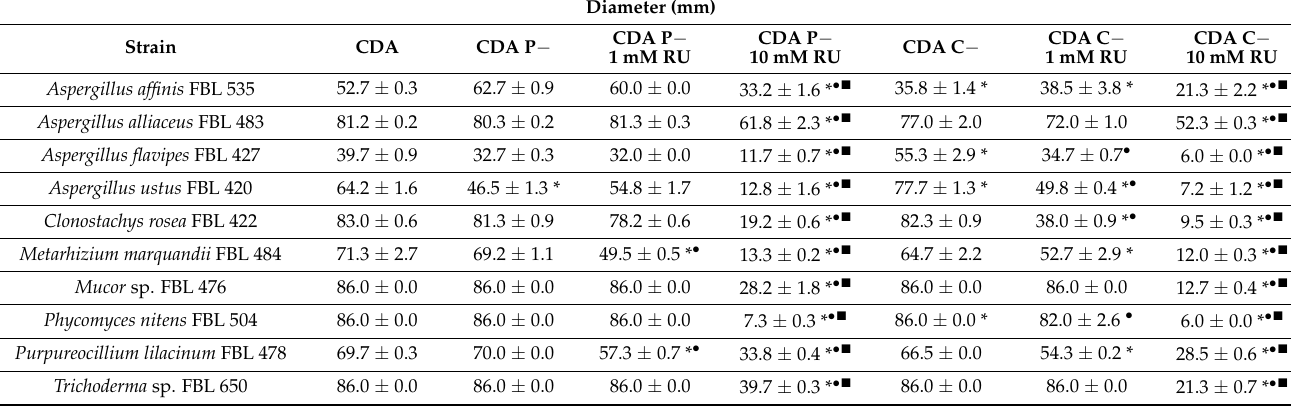
Table 4. Diametric values of fungal colonies after fourteen days of growth at 25 ◦ C on Czapeck dox agar (CDA) in enrichment conditions either for P (CDA P − ) or C (CDA C − ). The data are expressed as the mean ± standard error of independent biological replicates a